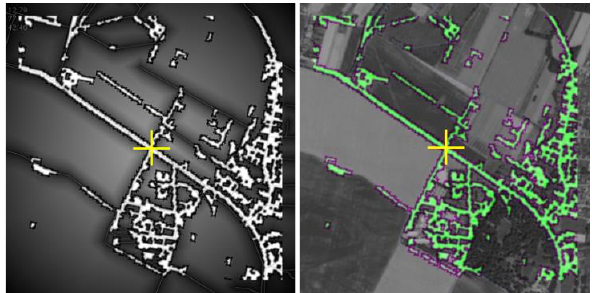
Figure 5. Average RMSE in pixels at 80% best extracted GCPs per image, for fourteen RapidEye level 1B